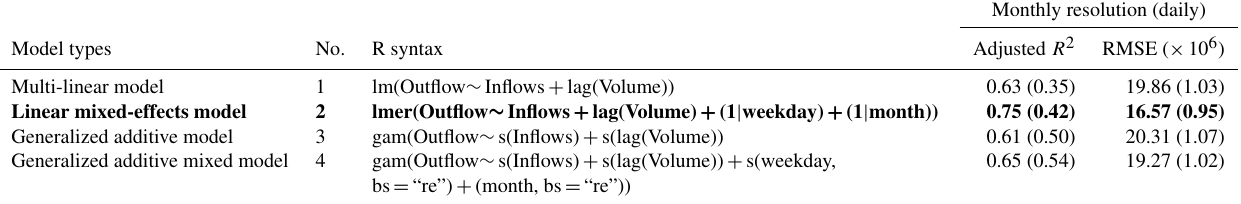
Table 2. Best of each model type and their performance indicators ( R 2 and the root mean square error, RMSE) at monthly resolution and at daily resolution in brackets. The best selected model is reported in bold. The syntax follows that of the R packages “lme4” (for the linear mixed-effects model) and “mgcv” (for the generalized additive models) with the “bs” term set to “re” to refer to the random effect in the generalized additive mixed model; “s” is the function used in definition of smooth terms within the gam model formulae. A full list of tested models and their features is reported in the